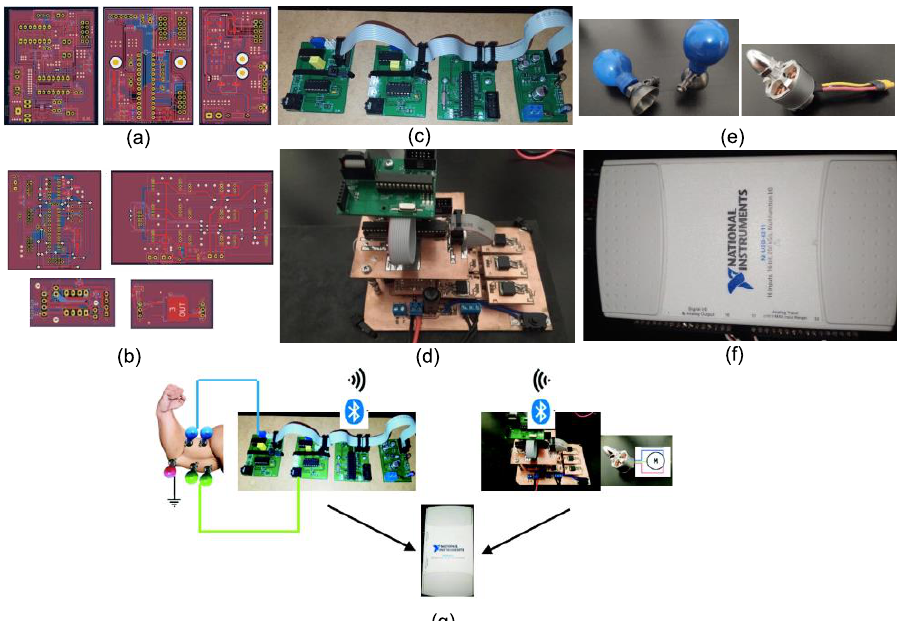
Figure 2. Design of printed circuit boards of data acquisition circuit (KiCad) ( a ), design of PCBs of BLDC motor controller ( b ), ready system of data acquisition without Bluetooth communication module ( c ), ready circuit of BLDC controller without connected Bluetooth communication module ( d ), suction-cup probes measuring and BLDC motor without integrated Hall sensors, ( e ) measuring card by National Instruments model NI USB-6211, ( f ) schematic diagram of the connection state or rest state of the entire system ( g ).